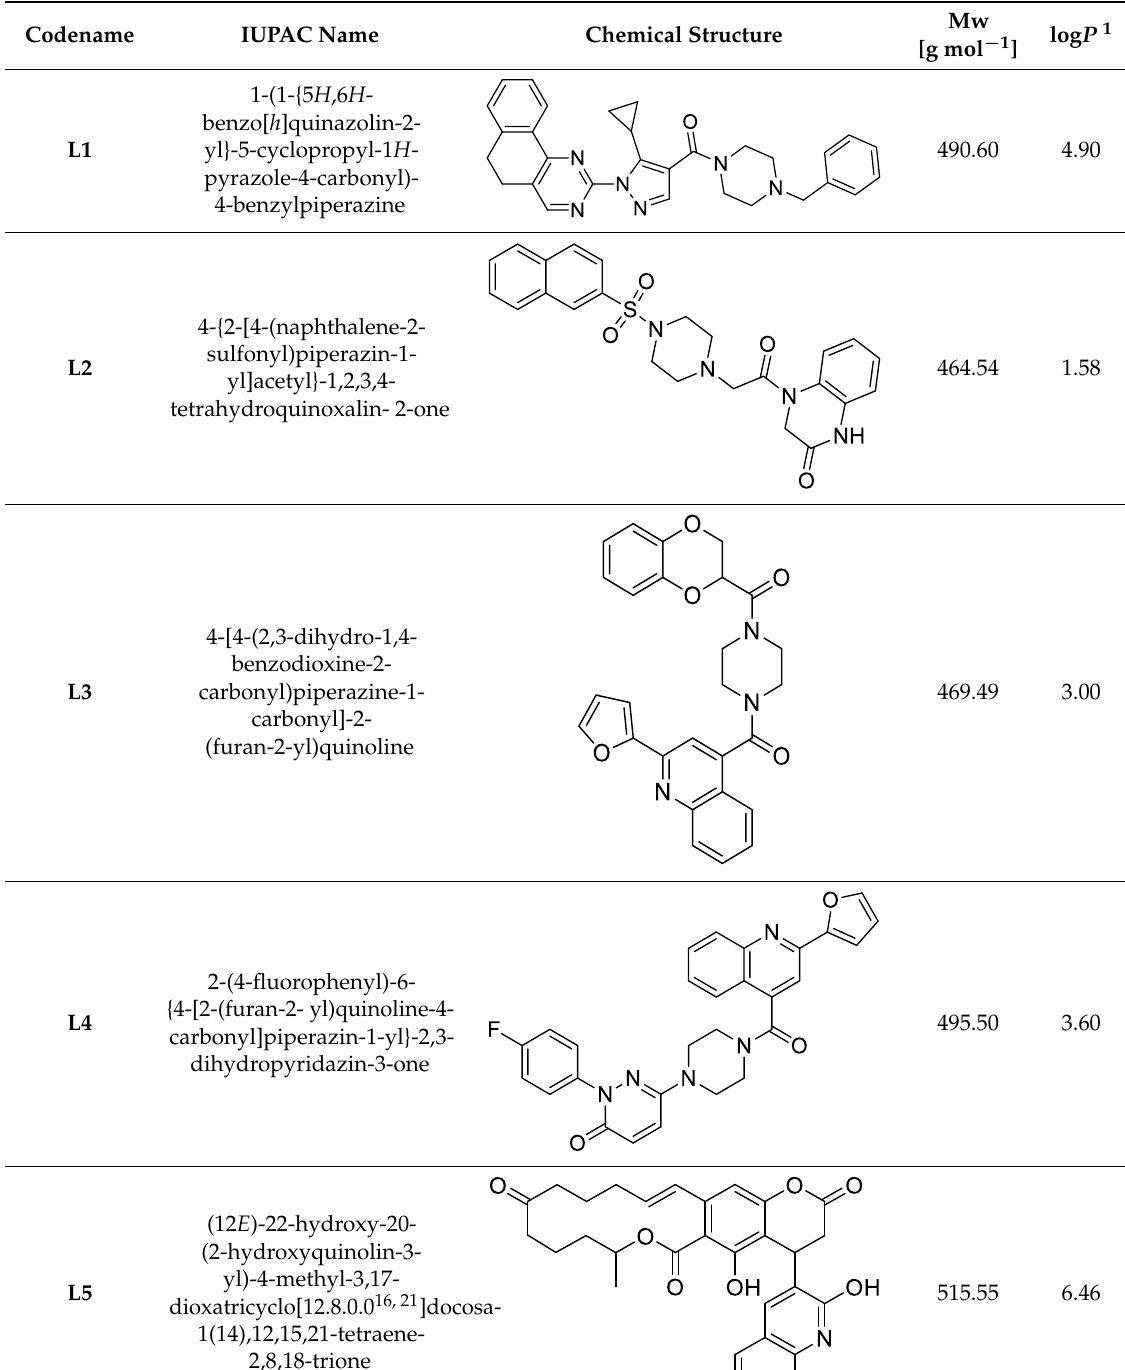
Table 1. Chemical characteristics of the studied compounds, L1 – L11 .